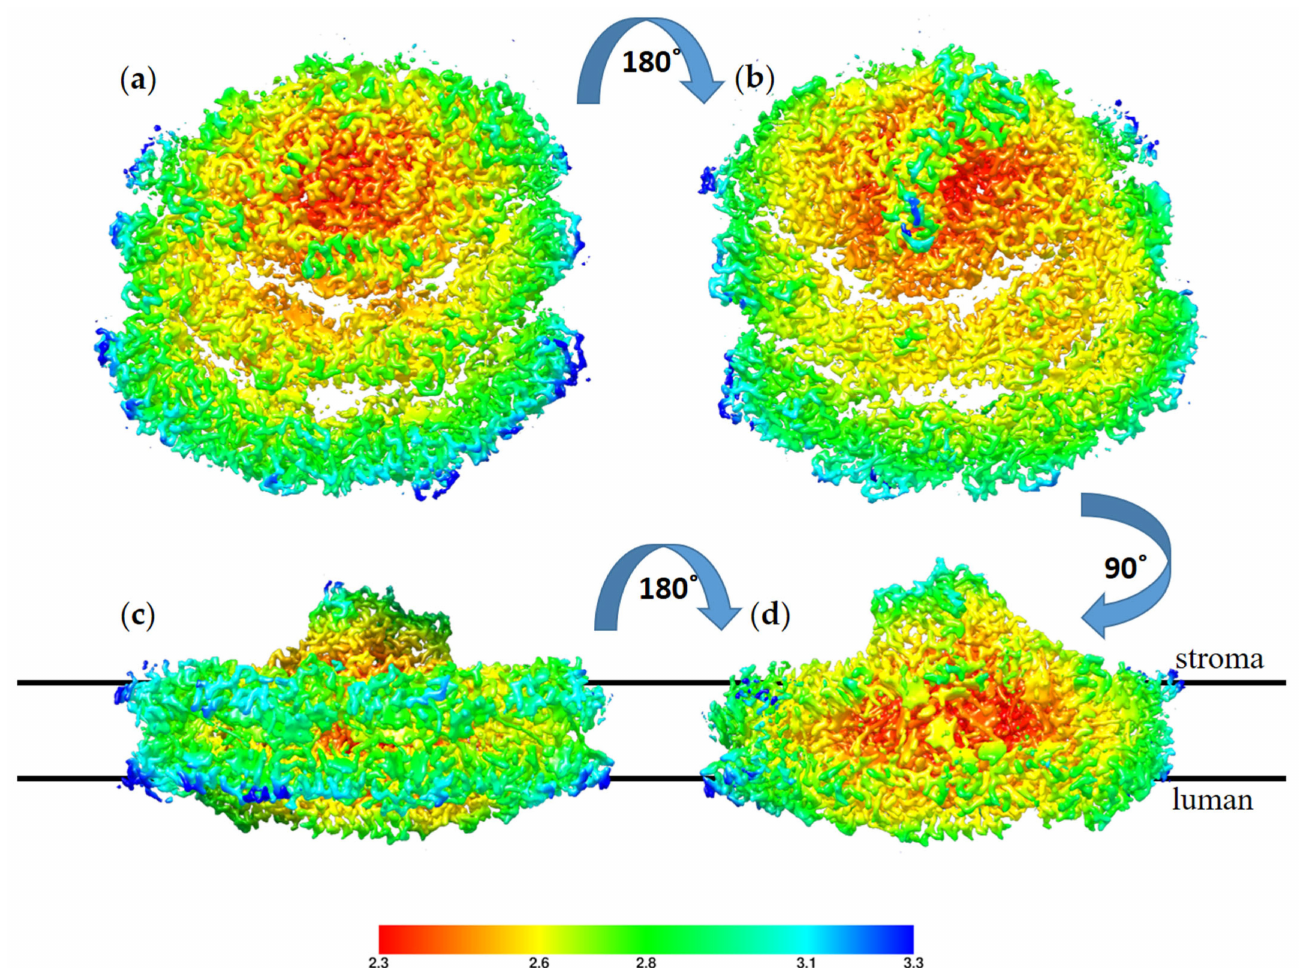
Figure 7. Local resolution of the TS9 PSI-8LHC (photosystem I (PSI)) structure, color coded as shown on the scale, with red for the best resolution at 2.3 Å and blue for the resolution at 3.3 Å. The structure is shown from four angels: ( a ) view from the luminal side, ( b ) view from the stromal side, ( c ) view from the PsaD pole of the membrane plane, and ( d ) view from the LHC pole of the membrane plane. The stroma and lumen positions are marked for the membrane plane